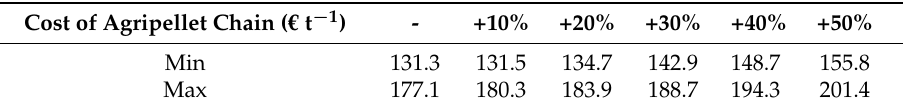
Table 11. Variation of the minimum and maximum agripellet chain cost (Scenario A), assuming a possible increase of fossil fuel